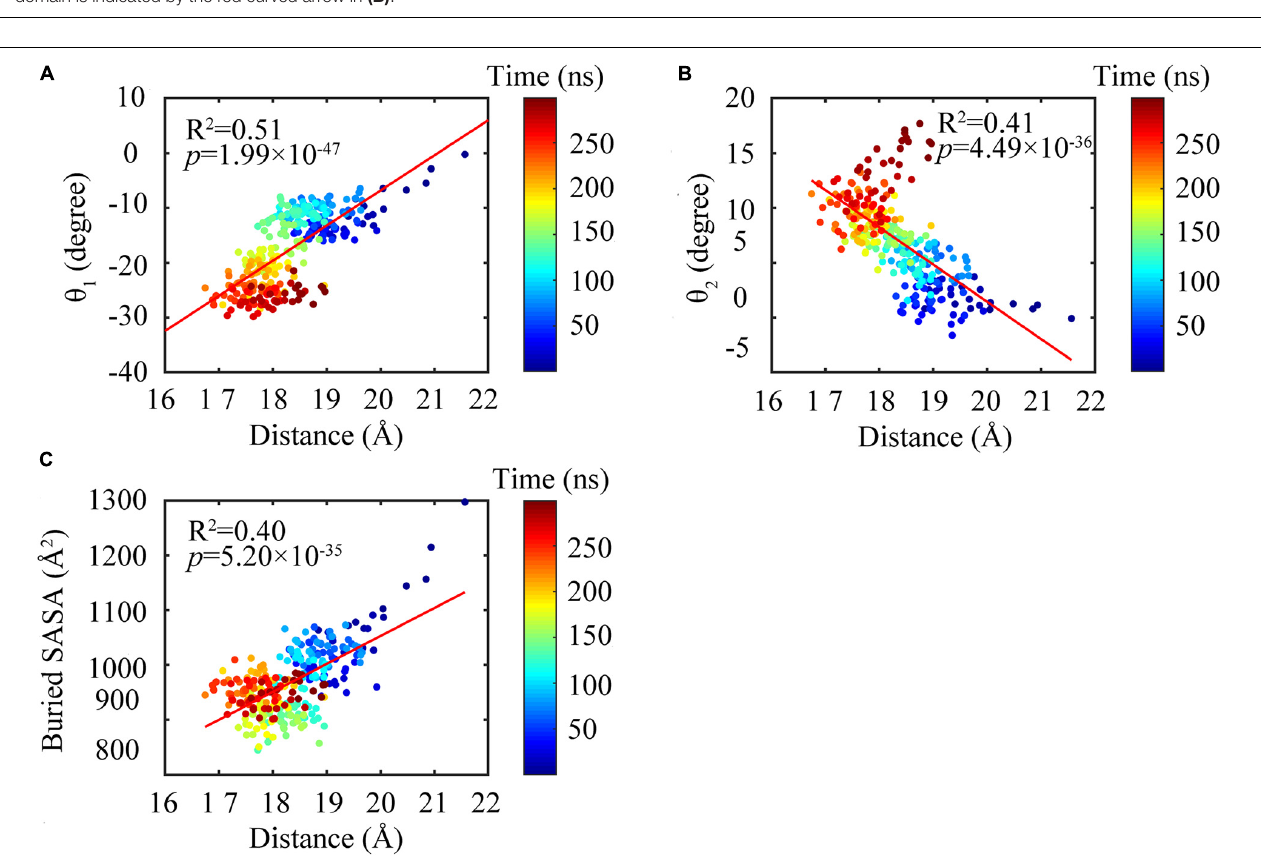
FIGURE 9 | Subunit conformations were highly correlated with the dimeric conformations. Highlighting the changing of the distance between the N- and C-terminal domains were highly correlated with bending angles θ 1 (A) and θ 2 (B) and buried SASA (C) .